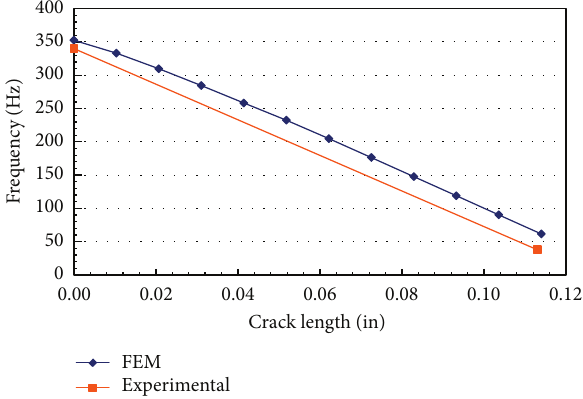
Figure 13: FEM and experimental natural frequency